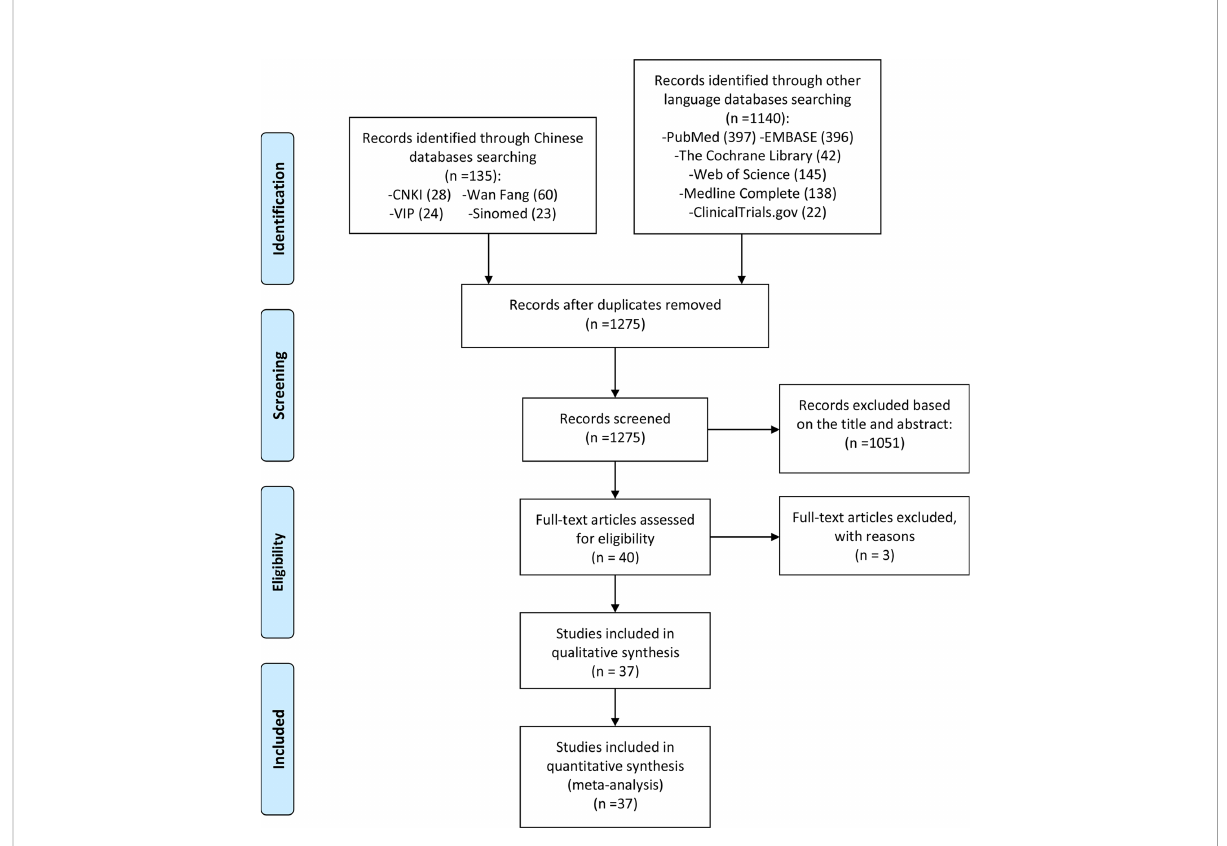
FIGURE 1 Flow diagram of clinical